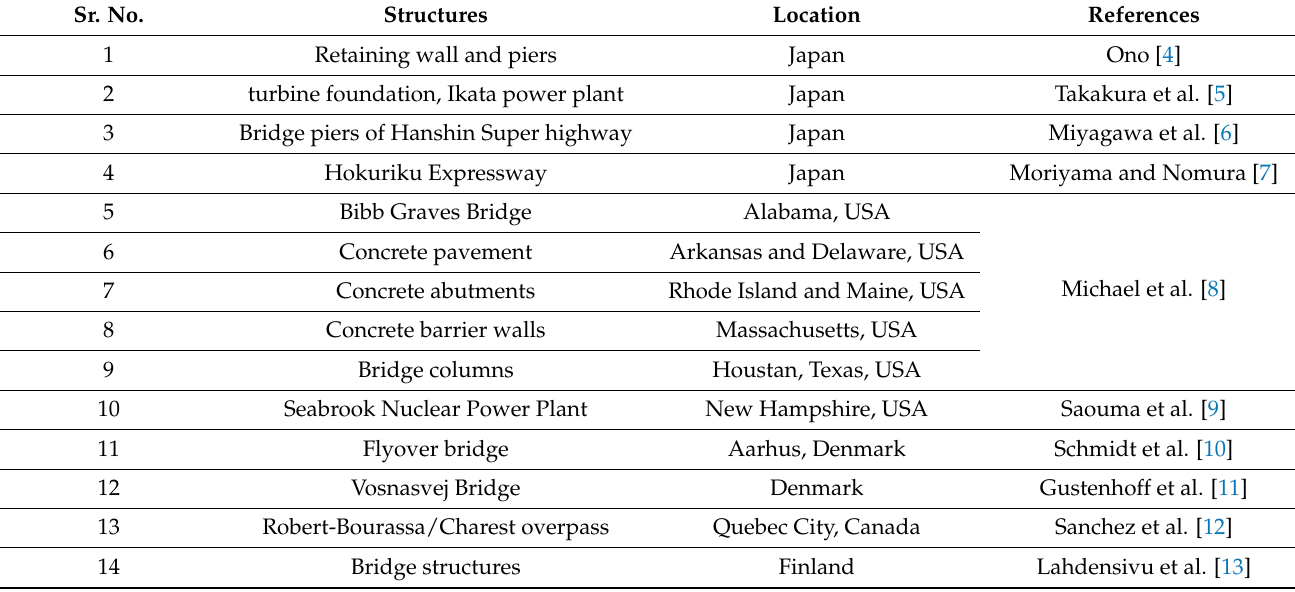
Table 1. Examples of ASR damaged structures around the